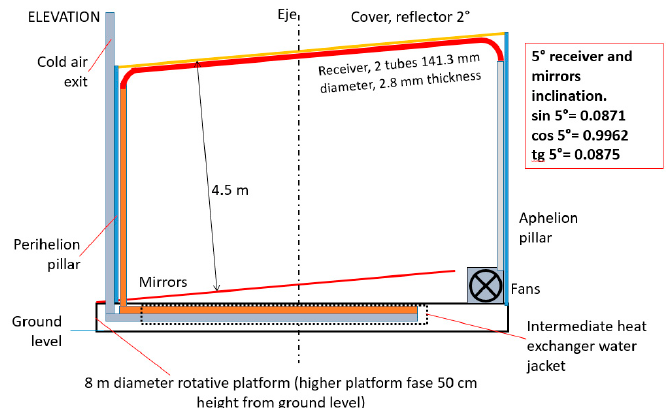
Figure 3. Elevation plan. Atmospheric air, impelled by two fans located at the entrance of the receiver double pipe, is used as the primary coolant of the receiver. After measuring the thermal data of the air hot stream, this is channelized into an intermediate heat exchanger, cooled by water, which is placed under the mirror bands, in order to study the problems and potential solutions for retrieving heat from the receiver. The water does not boil. It is not intended for a thermodynamic cycle. It is considered that the main use of future Sundial commercial units will be to process heat.